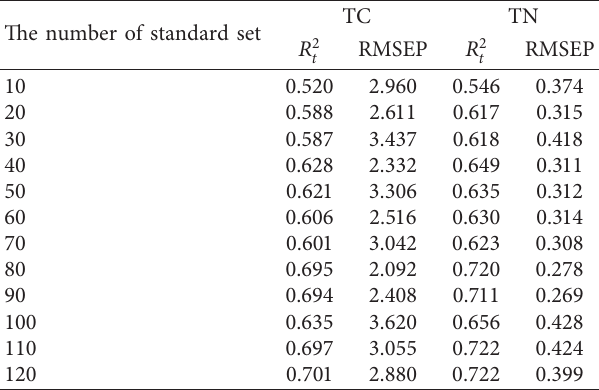
Table 7: Model results of soil samples TC and TN concentration by the spectral data of the hyperspectral camera.